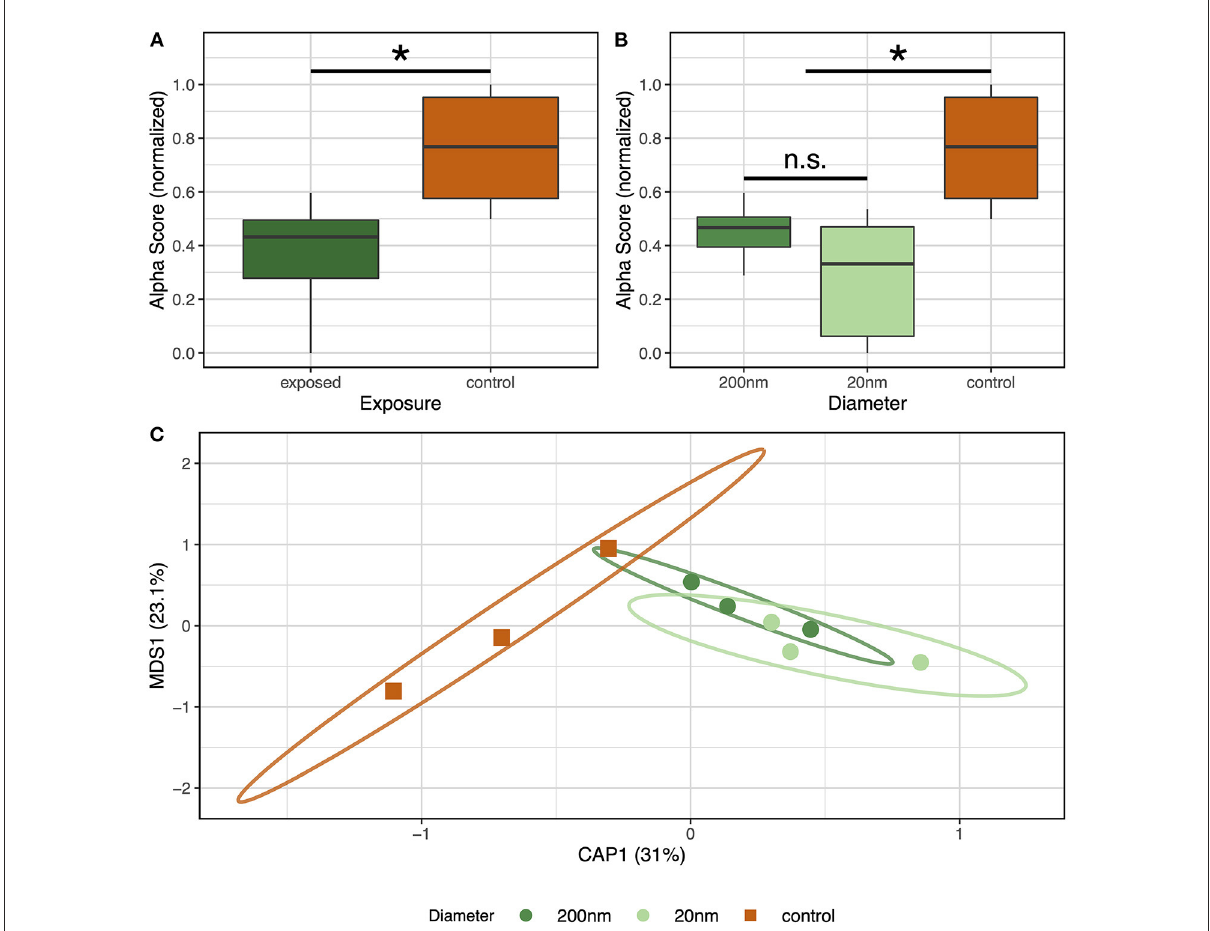
FIGURE5 Effects of 20 and 200nm PSNS on gut microbiome biodiversity and composition. Simpson’s and Shannon Indices of diversity shows that gut microbiome biodiversity is significantly reduced in mice that were (A) exposed to PSNS and (B) the size of the particle effects the severity